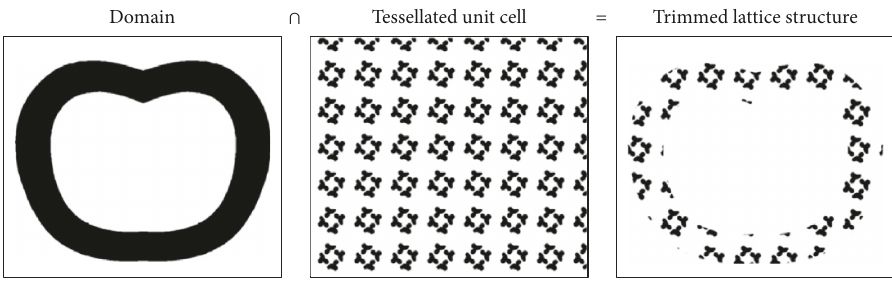
Figure 10: Generation of a trimmed structure by Boolean intersection [63].